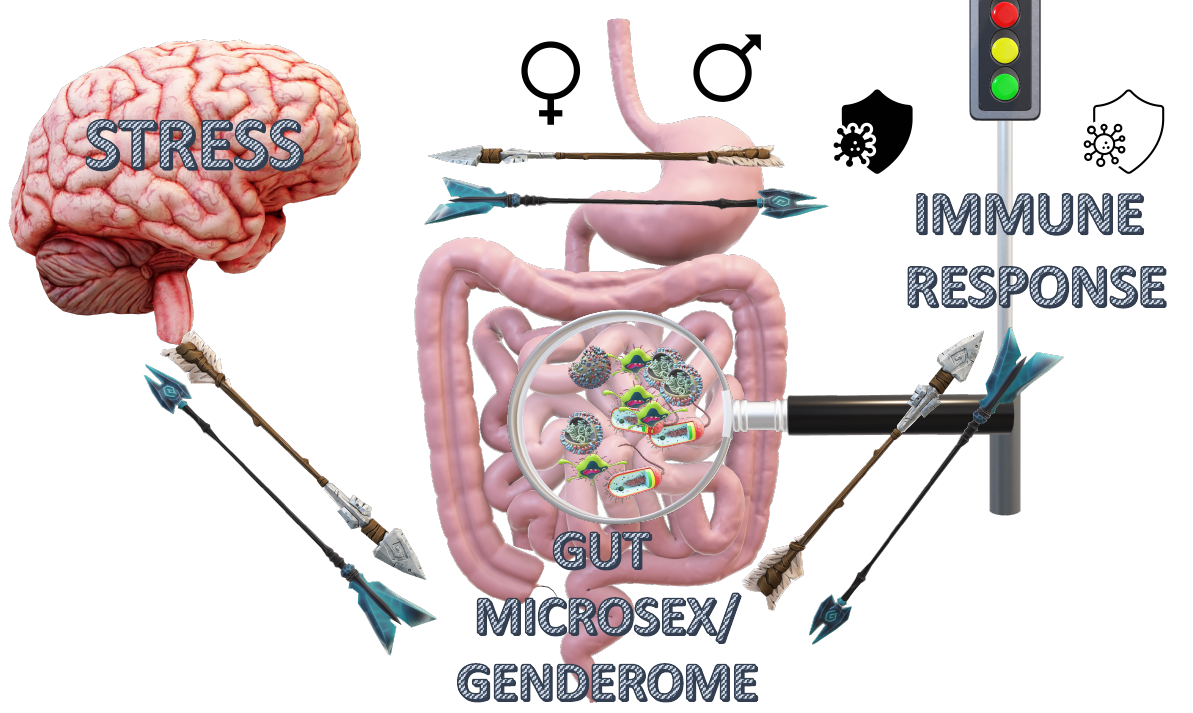
Figure 1. Concept of the